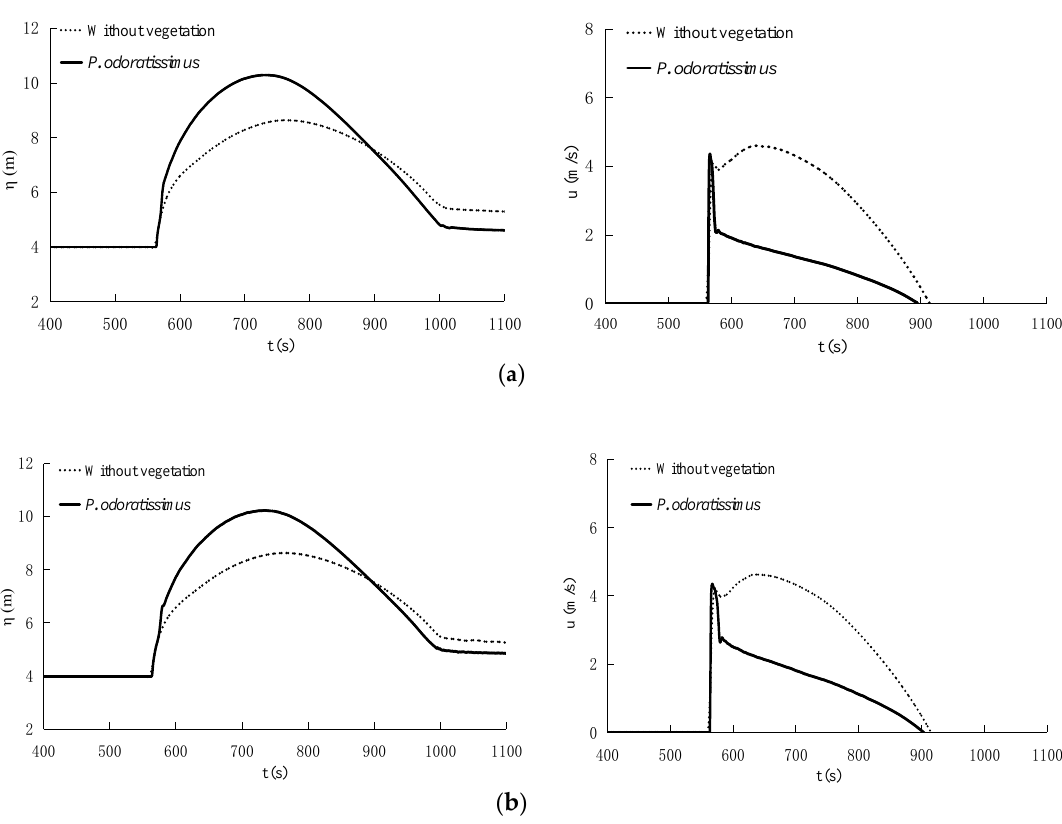
Figure 12. Flow structure in Case 1 at different times (( a ) T = 600 s, ( b ) T = 660 s, ( c ) T = 700 s).